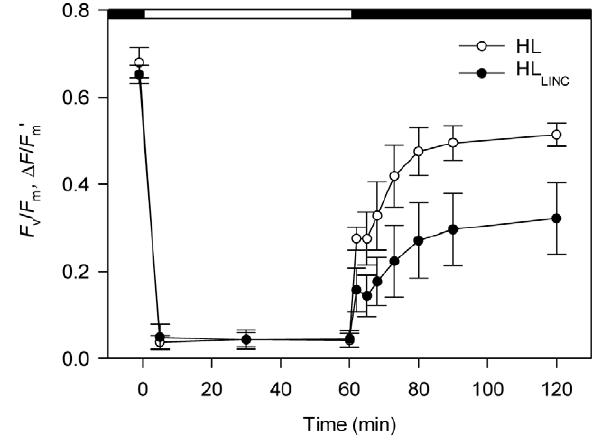
Figure 5. Variation in PSII maximum ( F v / F m ) and effective ( D F / F m 9 ) quantum yield in Phaeodactylumtricornutum . Measurements before and during exposure to 1 h of high irradiance (1,250 m mol photons m 2 2 s 2 1 ), and subsequent recovery in the dark. Treatments: HL (control samples); and HL LINC (LINC inhibited samples). Mean 6 standard deviation (n=5). doi:10.1371/journal.pone.0038162.g005 Results on non-photochemical quenching in P. tricornutum